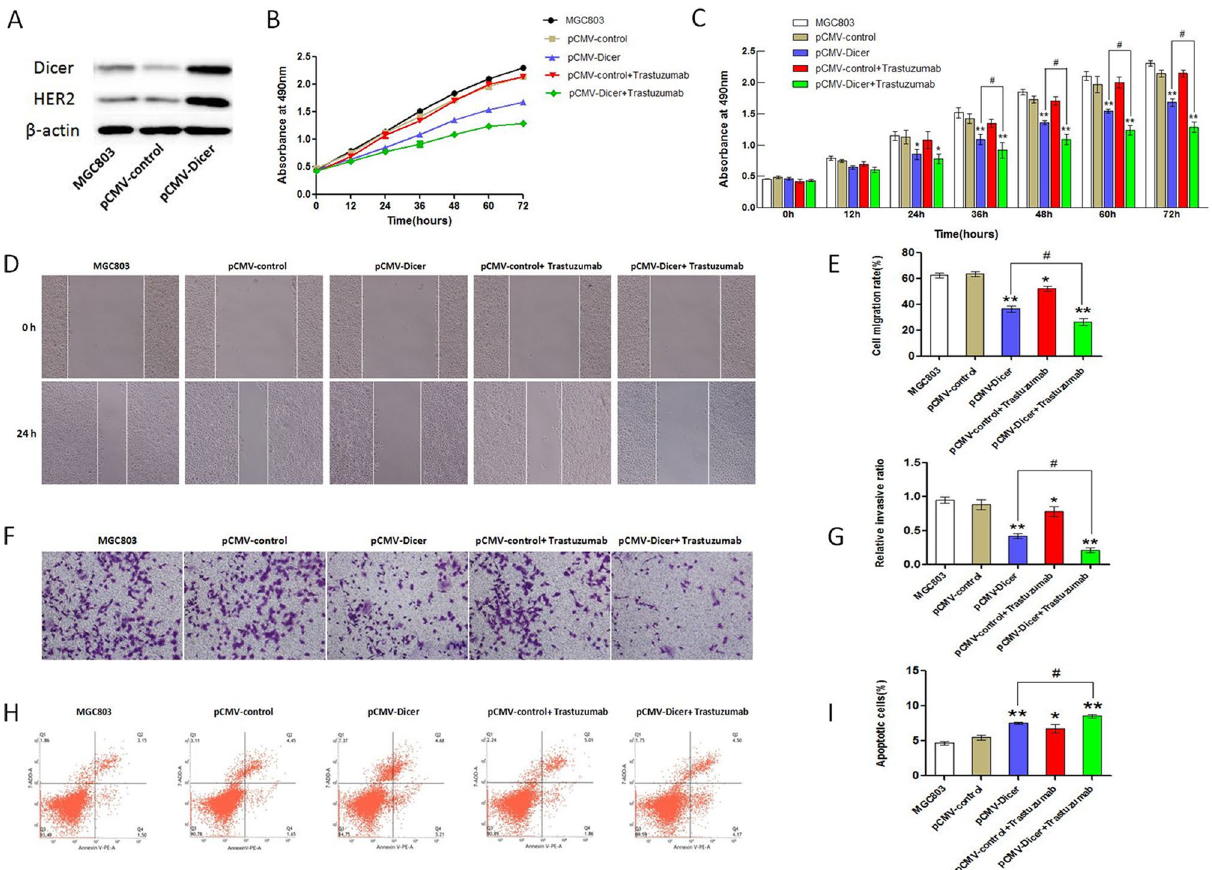
Figure 2. Trastuzumab enhance the Dicer related inhibition for MGC803 cell. ( A ) Western Blot of Dicer and HER2 in MGC803 cells. The grouping of gels/blots cropped from diferent parts of the same gel, the full blots are shown in Fig. S4; ( B , C ) The MGC803 cells proliferation measured with CCK-8 assay; ( D , E ) The MGC803 cells migration measured by wound healing assay; ( F , G ) The MGC803 cells invasion measured with transwell assay; ( H , I ) The measurement of apoptosis rate with flow cytometry for MGC803 cells. *P < 0.05, **P < 0.01, # P < Dicer inhibited the growth of GC cells.